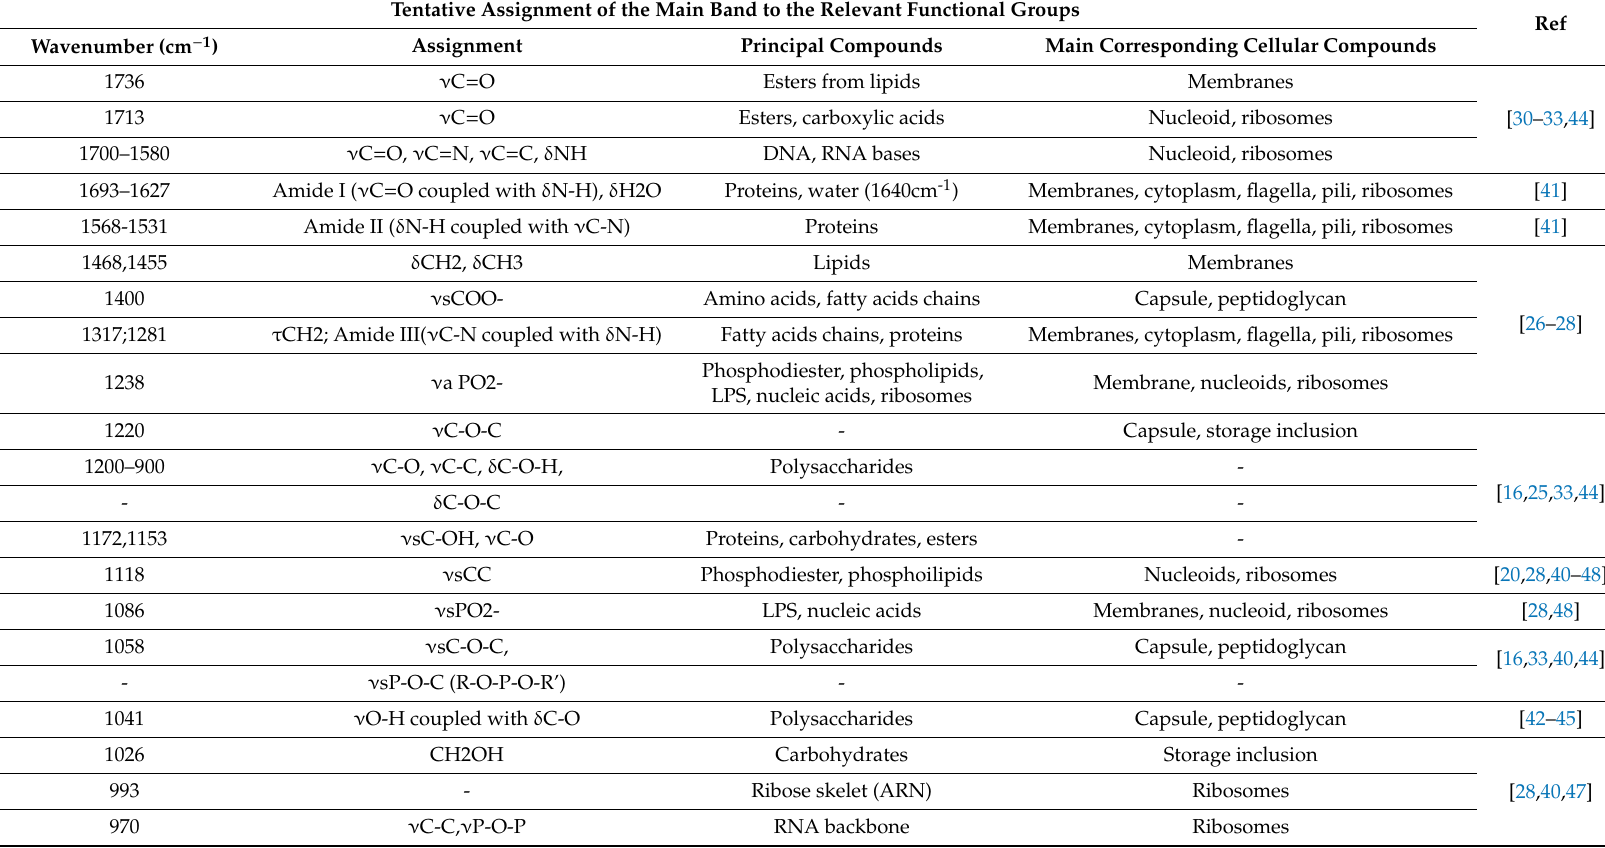
Table 1. Assignment of main infrared vibration bands in the 3000–900 cm − 1 region of ATR-FTIR spectrum of Pseudomonas fluorescens pellet harvested by centrifugation. Key: ν —stretching, δ —bending, τ —twist, a-asymmetric, s—symmetric,